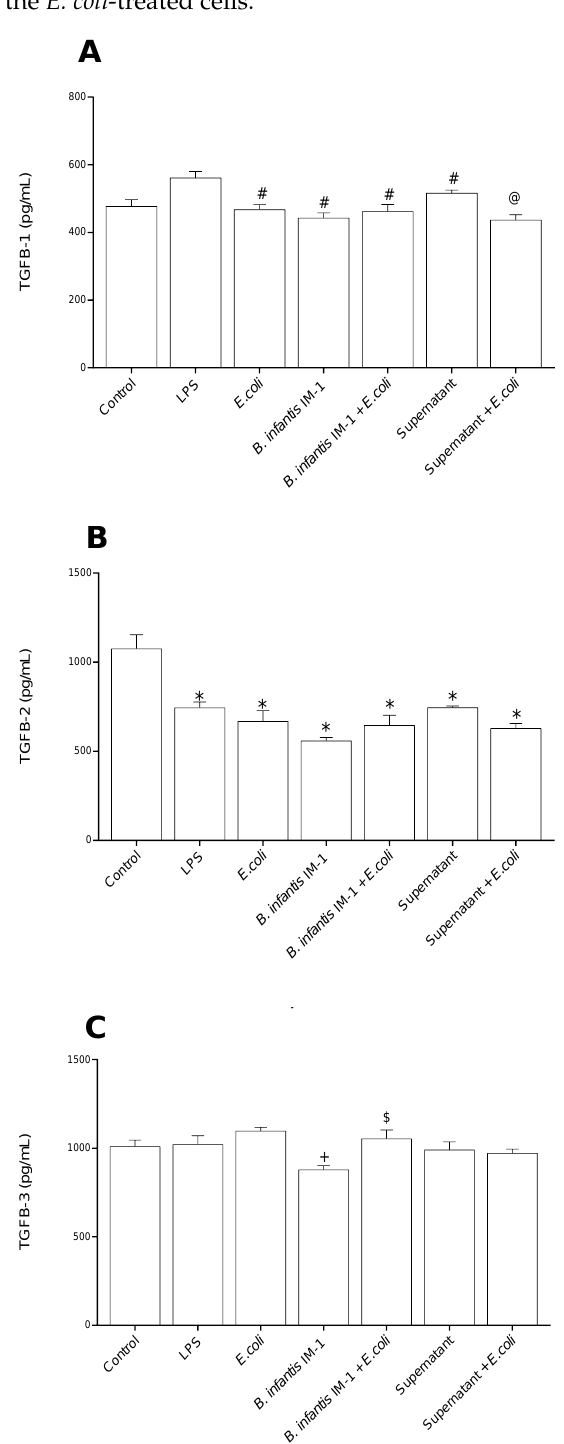
Figure 3. TGF- β levels in the culture medium of Caco-2 cells after 8 h of treatments. ( A ) TGF- β 1. ( B ) TGF- β 2. ( C ) TGF- β 3. Results are expressed in pg/mL as the mean ± SEM of three independent experiments. * p < 0.05 vs. control (untreated cells); # p < 0.05 vs. LPS; + p < 0.05 vs. E. coli; $ p < 0.01 vs. B. infantis IM-1 ® ; @ p < 0.001 vs. supernatant.